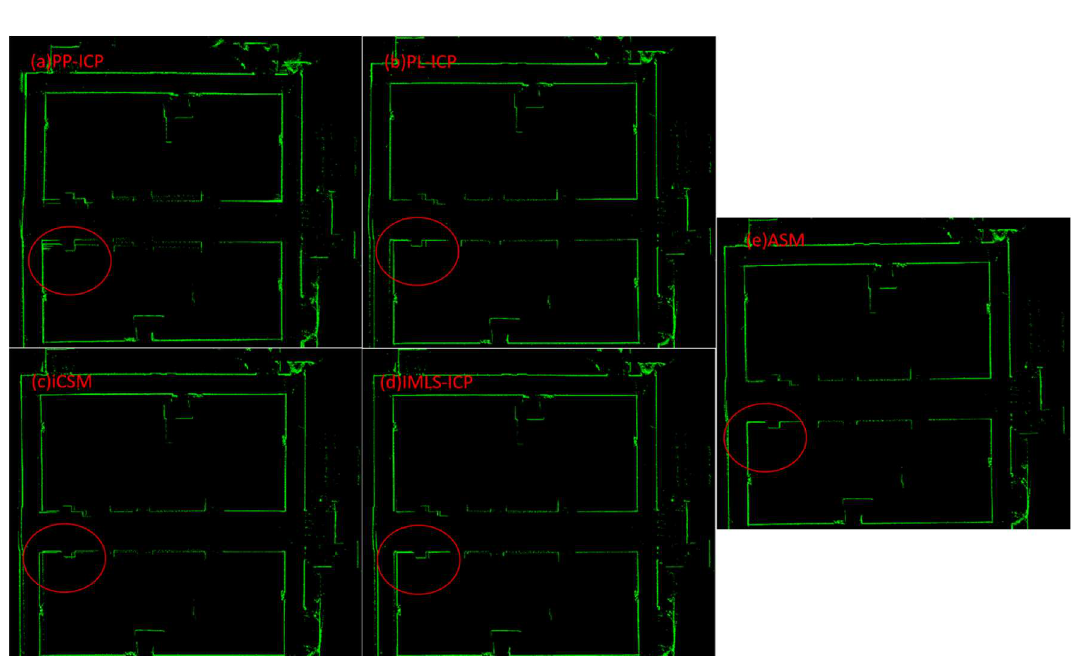
Figure 9. Office building maps.